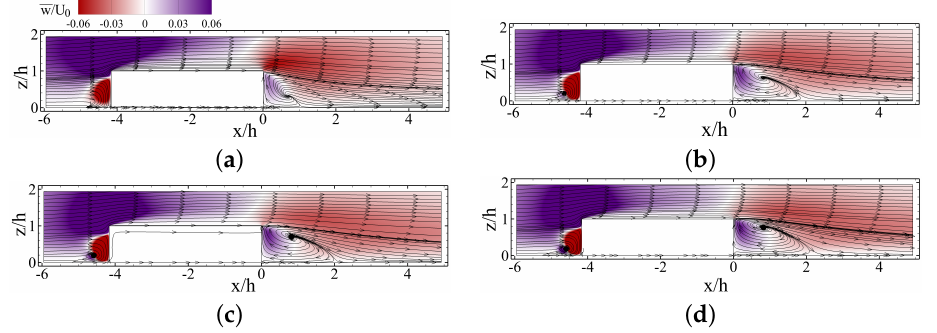
Figure 24. Streamlines on a side view ( xz -) of the long prism ( DR = 4.17) at y / h = 0 highlighted by the normal component of the velocity vector at Re = ( a ) 50; ( b ) 150; ( c ) 200 and ( d )